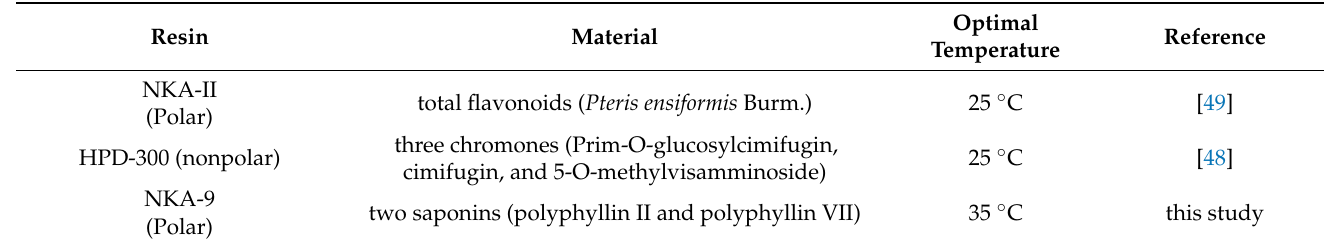
Table 7. Comparison of optimal temperature for different resins.